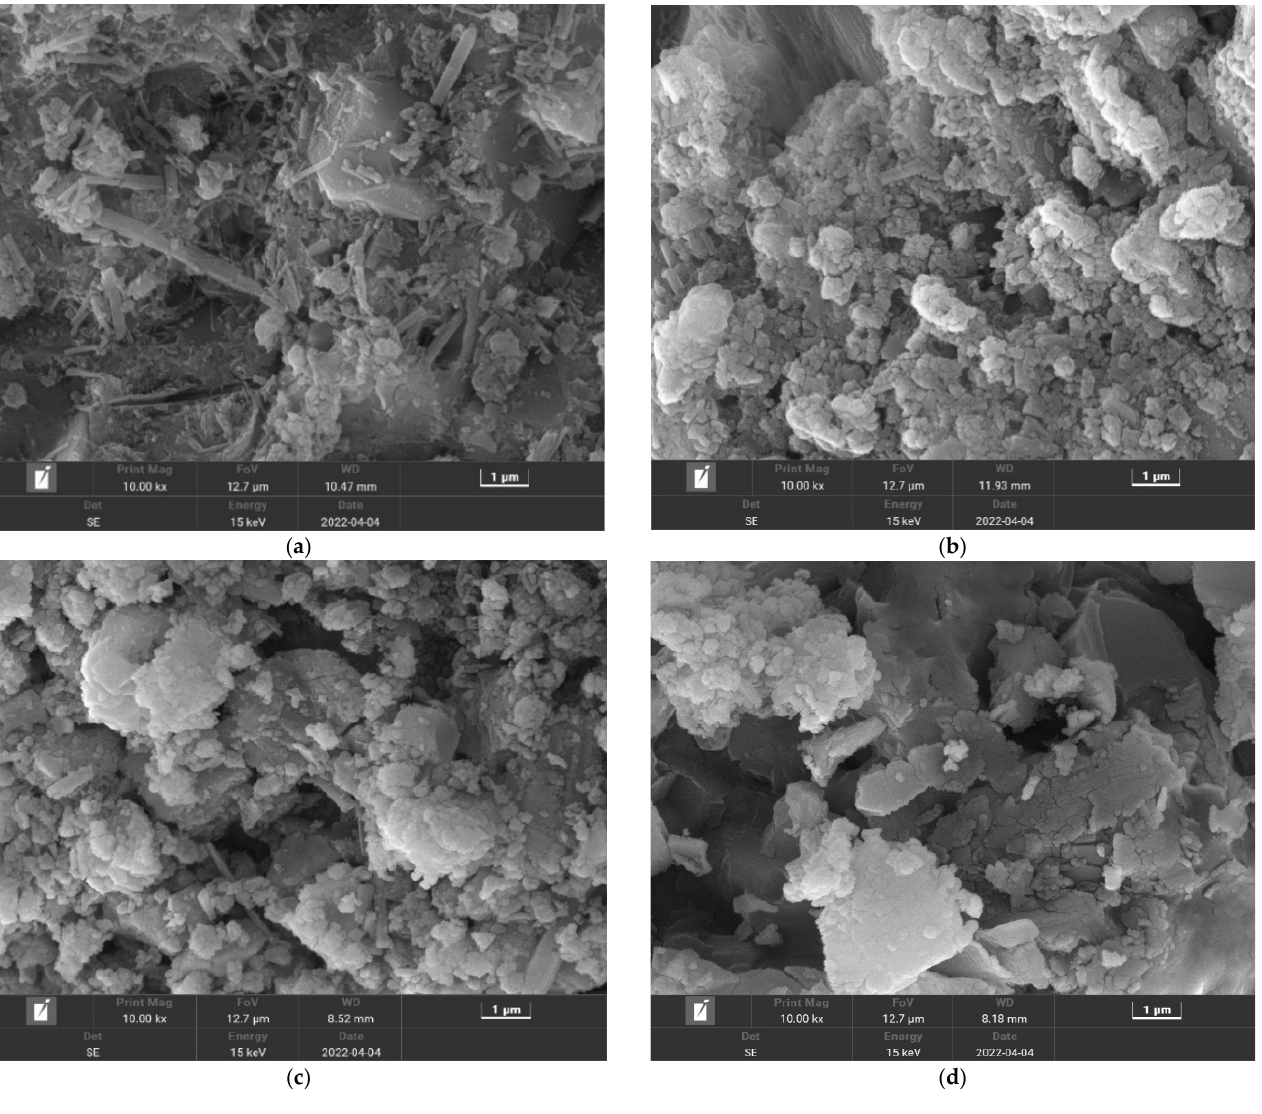
Figure 9. Microstructure of cement mortar with NA: (a) 1% NA; (b) 2% NA; (c) 4% NA; (d) 8% NA.